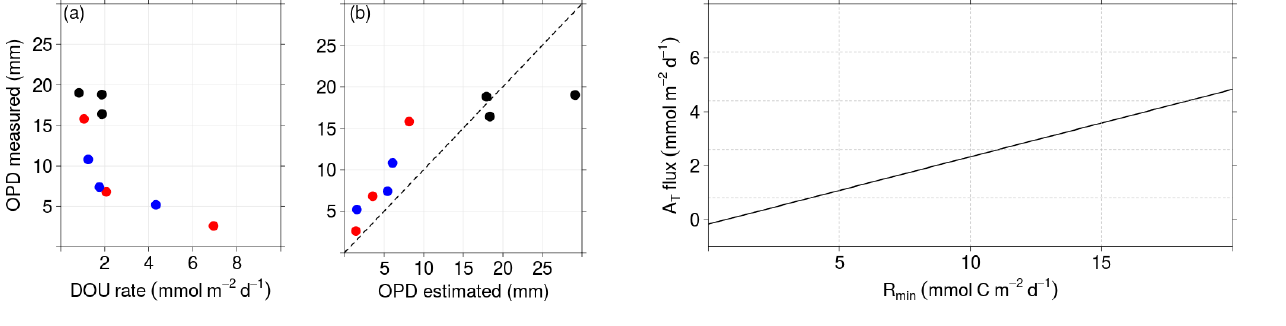
Figure 7. (a) Oxygen penetration depth (OPD) plotted versus dif- fusive oxygen uptake (DOU) rate. (b) Correlation between mea- sured OPD and theoretical OPD. Dashed line: 1:1 line; red sym- bols: SNS; blue symbols: NNS; black: SKNT. For calculation and details, see the text.